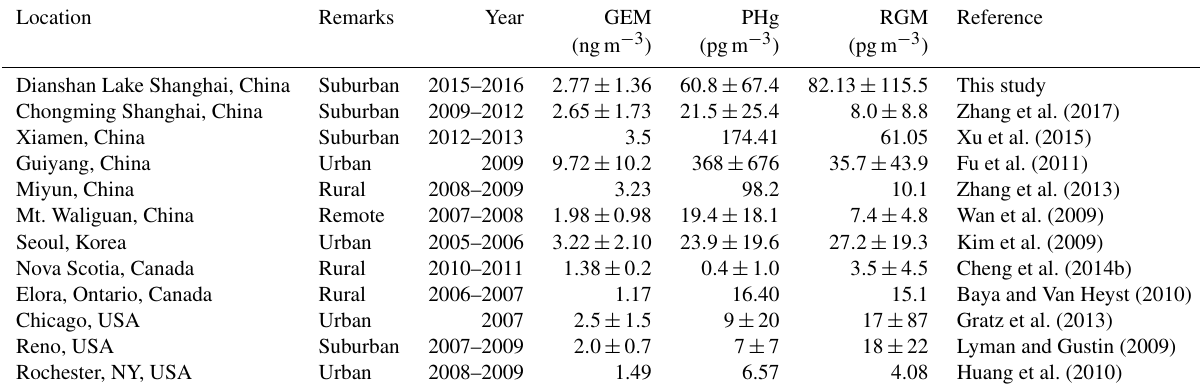
Table 1. The concentrations of speciated atmospheric mercury in this study and at other sites around the world.